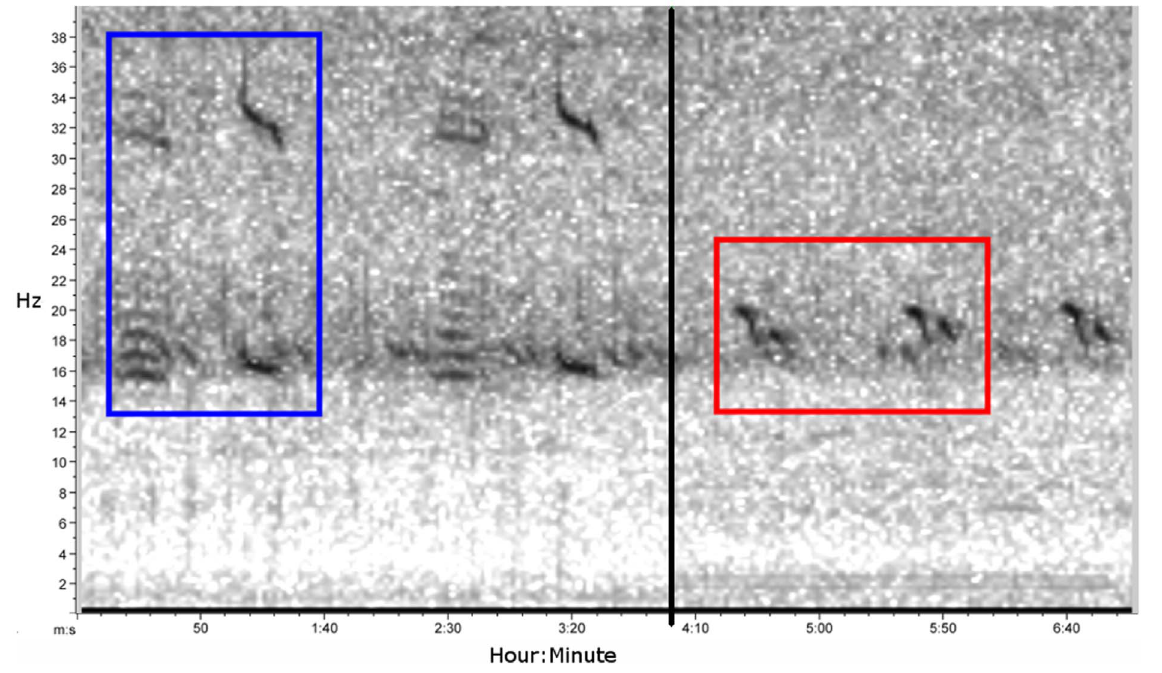
Figure 1. Spectrogram showing the ENP and WNP blue whale song calls. These calls were recorded on a hydrophone in the Gulf of Alaska at different times; the blue box shows the ENP song call and the red box the WNP song call. The clear distinction between the two is used to differentiate the presence and absence of the two populations.